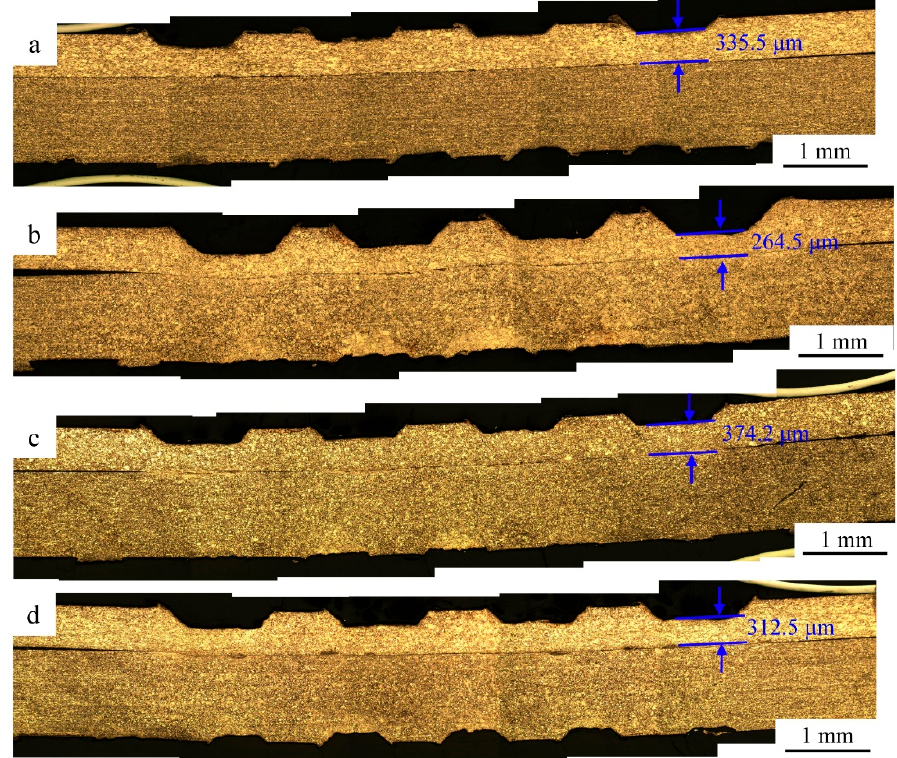
Figure 5. Optical micrographs of the cross-sections of the weld zone for the joints without ( a —0.45 MPa, b —0.55 MPa) and with alcohol ( c —0.45 MPa, d —0.55 MPa).